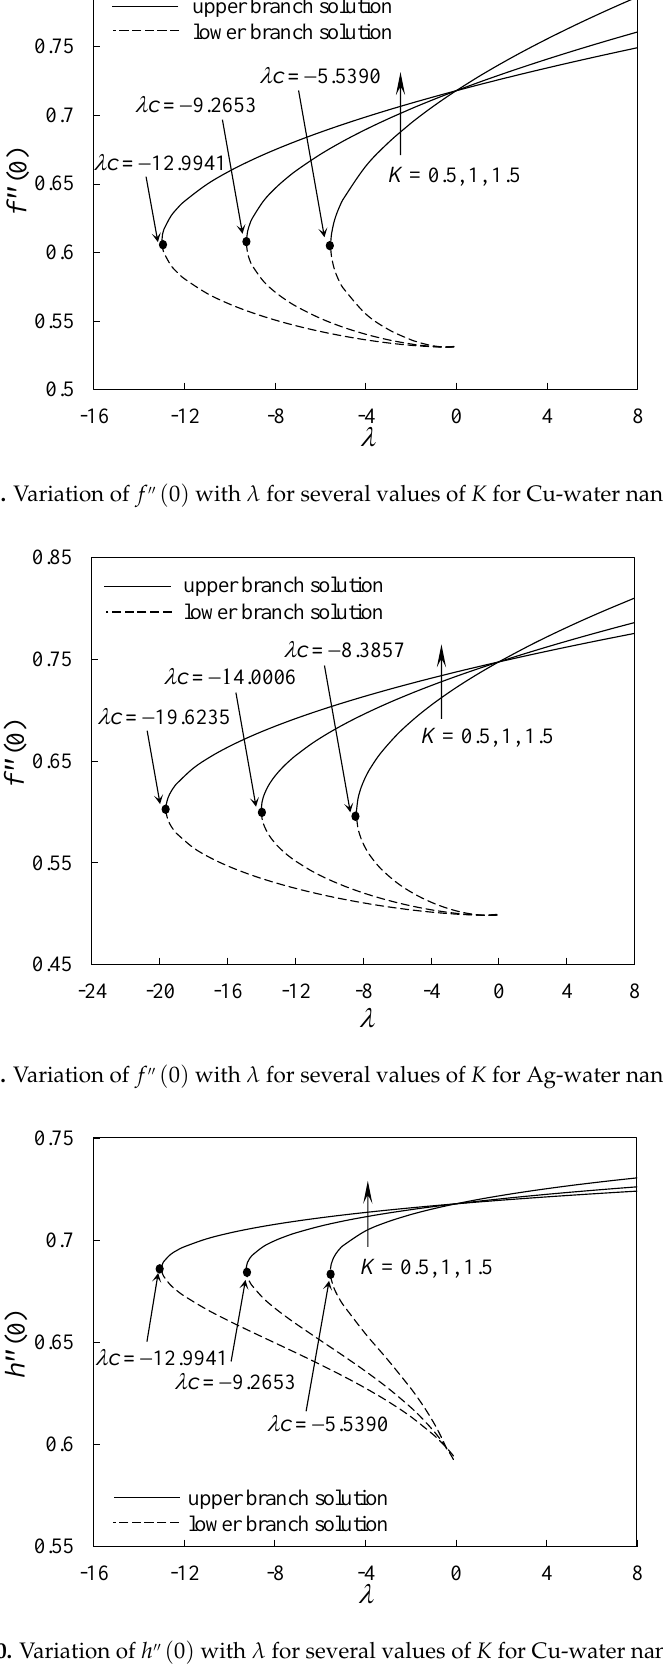
  0 h  Figure 10. Variation of h (cid:48)(cid:48) ( 0 ) with λ for several values of K for Cu-water Figure 10. Variation of with  for several values of K for Cu-water nanofluid.